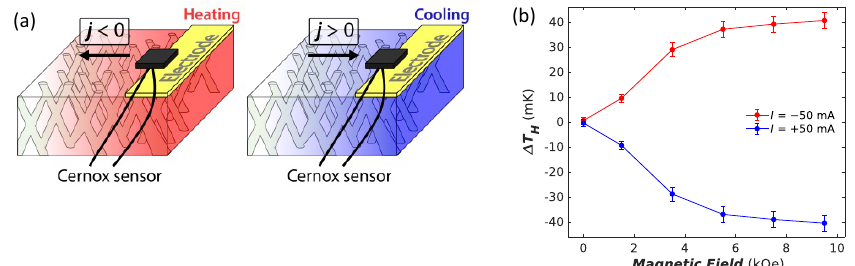
Figure 16. ( a ) schematics of a set-up for direct observation of Peltier and magneto-Peltier effects; a Cernox thermometer is used to monitor the temperature changes at the junction between the NWs and the electrode; ( b ) measured temperature changes ∆ T H at the Peltier junction in the Co/Cu CNWs (105 nm in diameter and packing density of 22%) during the magnetic field sweep for a DC current of 50 mA and +50 mA. The magneto-Peltier effect leads to heating and cooling at the saturation − field depending on current flow direction (from [65]). figure adapted from ref. [65] with permission of the